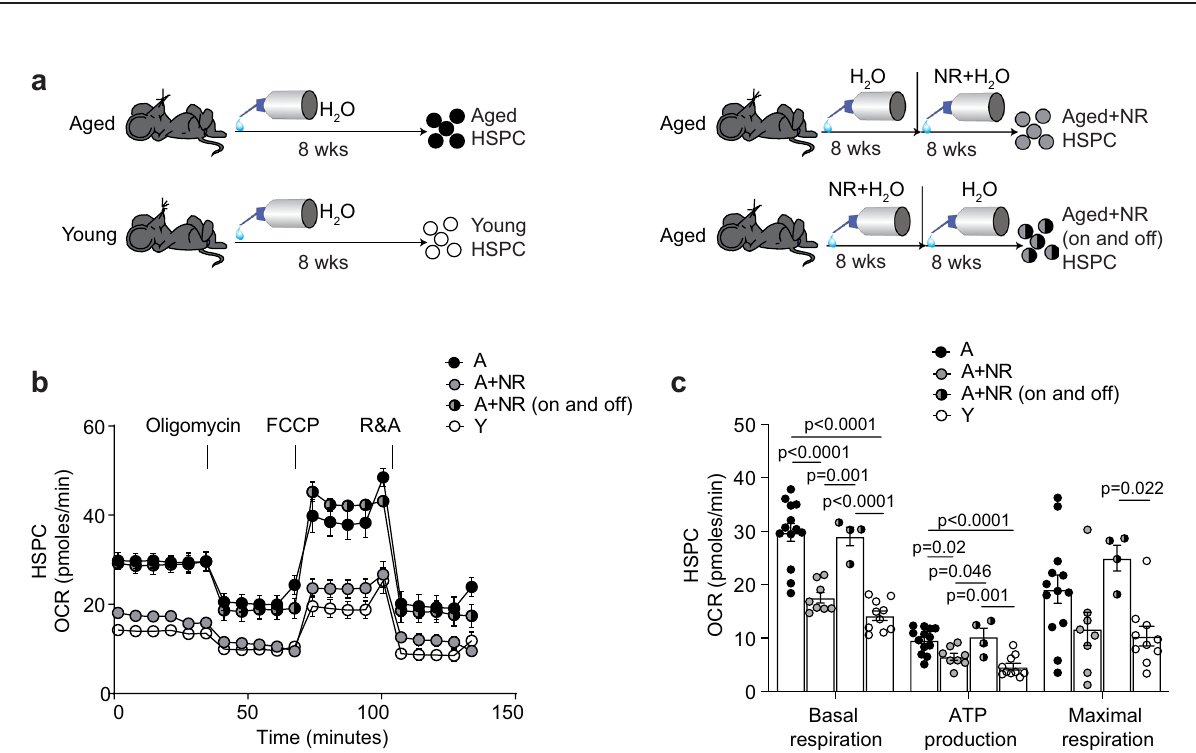
Fig. 6 Metabolic restoration is dependent on continued administration of NR. a Schematic representation of the experimental setup. b Quanti fi cation of oxygen consumption rate (OCR) in freshly isolated HSPC from aged mice ( n = 13, biological replicates), NR-treated aged mice ( n = 8, biological replicates), aged mice receiving NR prior to 2 months rest ( n = 4, biological replicates) and young mice ( n = 10, biological replicates), as described in a . OCR was measured under basic conditions followed by subsequent addition of the oligomycin, FCCP and R&A, as indicated. c Basal respiration, ATP production and maximal respiration levels in aged ( n = 13, biological replicates), NR-treated aged ( n = 8, biological replicates), aged mice receiving NR prior to 2 months rest ( n = 4, biological replicates) and young HSPC ( n = 10, biological replicates). Data are mean ± s.e.m. and is a pool from three independent experiments. Statistical analyses were performed using ordinary one-way ANOVA, p < 0.0001 (overall for basal respiration), <0.0001 (overall for ATP production), p = 0.0084 (overall for maximal respiration capacity) with individual groups compared using Tukey ’ s multiple comparisons test, p -values indicated for c . Only statistically signi fi cant comparisons of individual groups are indicated. NR nicotinamide riboside, HSPC hematopoietic stem and progenitor cells, Y young, A aged, A + NR NR-treated aged animal. Source data are provided as a Source Data